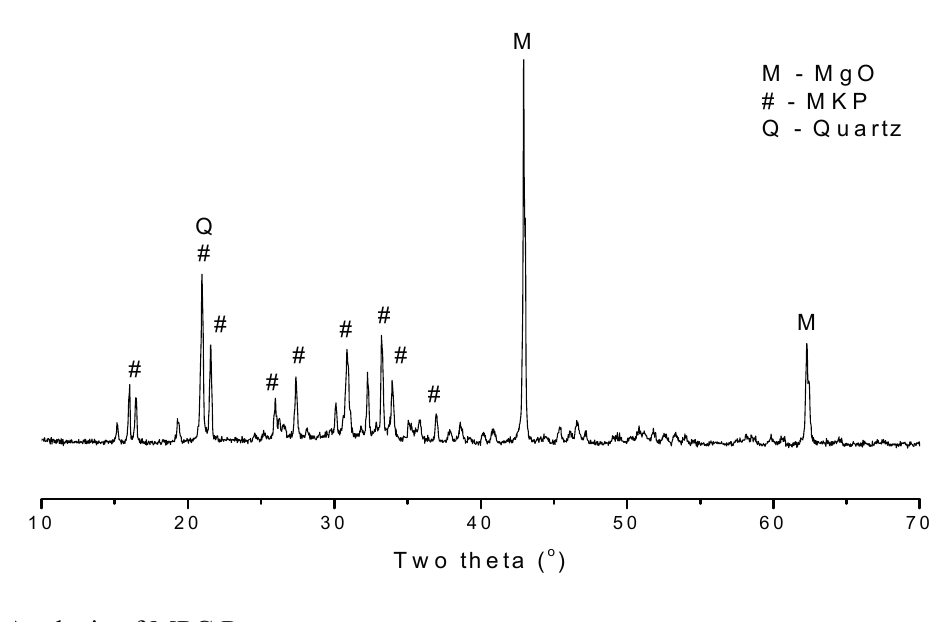
Figure 11. XRD of MPC